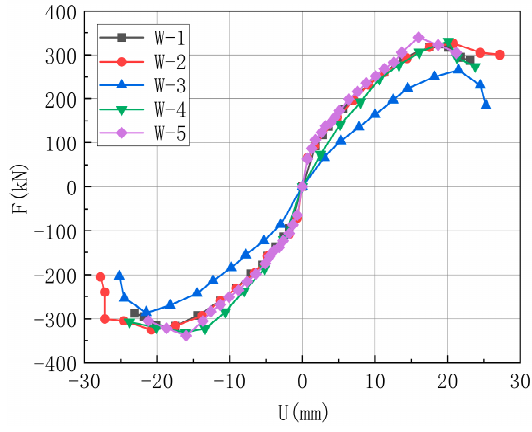
Figure 9. Skeleton curves of specimens.